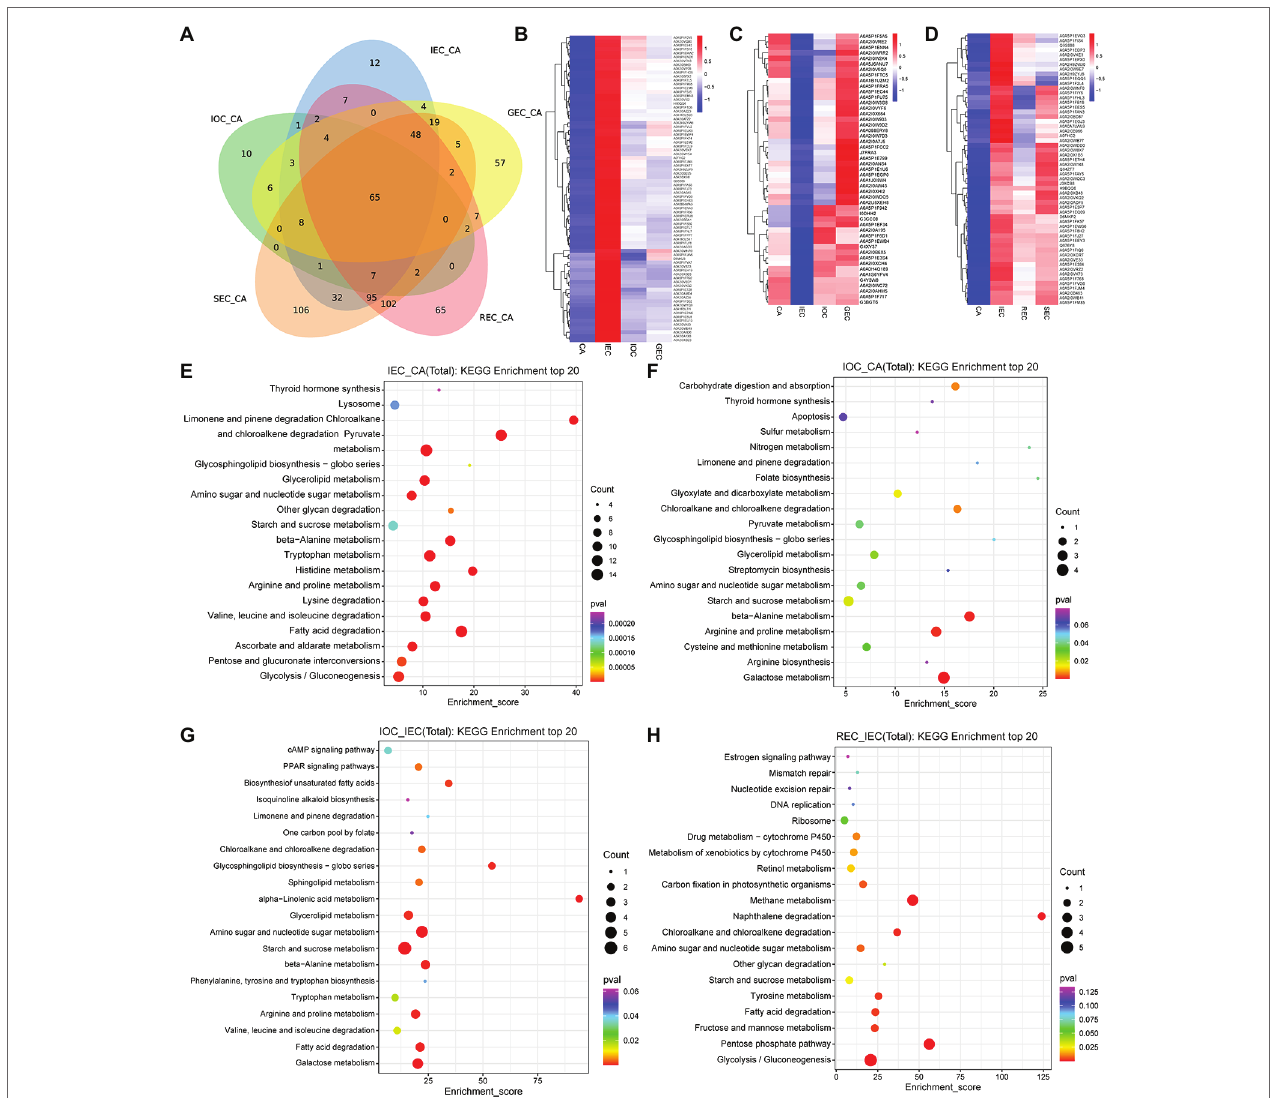
FIGURE 3 | Accumulation analysis and quantitative comparison of DAPs with different directions and stages of cell differentiation in A. praecox . (A) Venn diagram of DAPs among five compared pairs (IEC/CA, IOC/CA, GEC/CA, REC/CA, and SEC/CA). (B) Hierarchical clustering analysis (HCA) of DAPs concerning CA differentiation direction; the cluster showed DAPs with higher accumulation in IEC. The horizontal axis represents the sample clusters, and colors from blue to red indicate protein accumulation from low to high, the same below. (C) HCA of DAPs concerning CA differentiation direction; the cluster showed DAPs with lower accumulation in IEC. (D) HCA of DAPs concerning CA differentiation stage. (E) KEGG pathway enrichment of the comparative analyses in IEC/CA. The enrichment score is the percentage of members out of the total number detected. The bubble size represents the number of members detected in the KEGG pathway, and the color of the bubble represents the p -value, the same below. (F) KEGG pathway enrichment of the comparative analyses in IOC/CA. (G) KEGG pathway enrichment of the comparative analyses in IOC/IEC. (H) KEGG pathway enrichment of the comparative analyses in